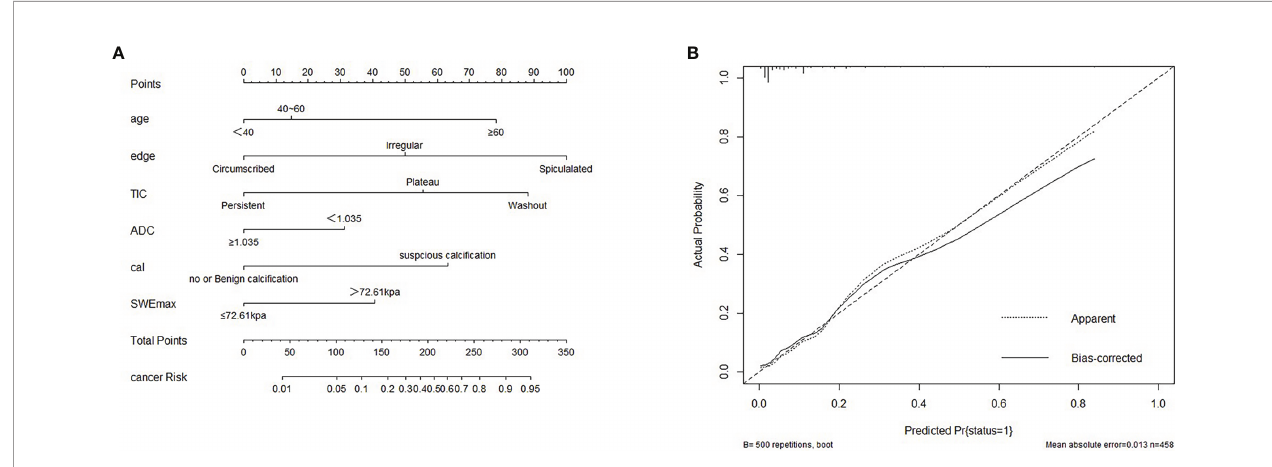
FIGURE 1 | (A) Nomogram for predicting benign and malignant mass in category 4A patients. (B) Calibration curve based on model. cal, calci fi cation morphology; TIC, time – signal intensity curve; ADC, apparent diffusion coef fi